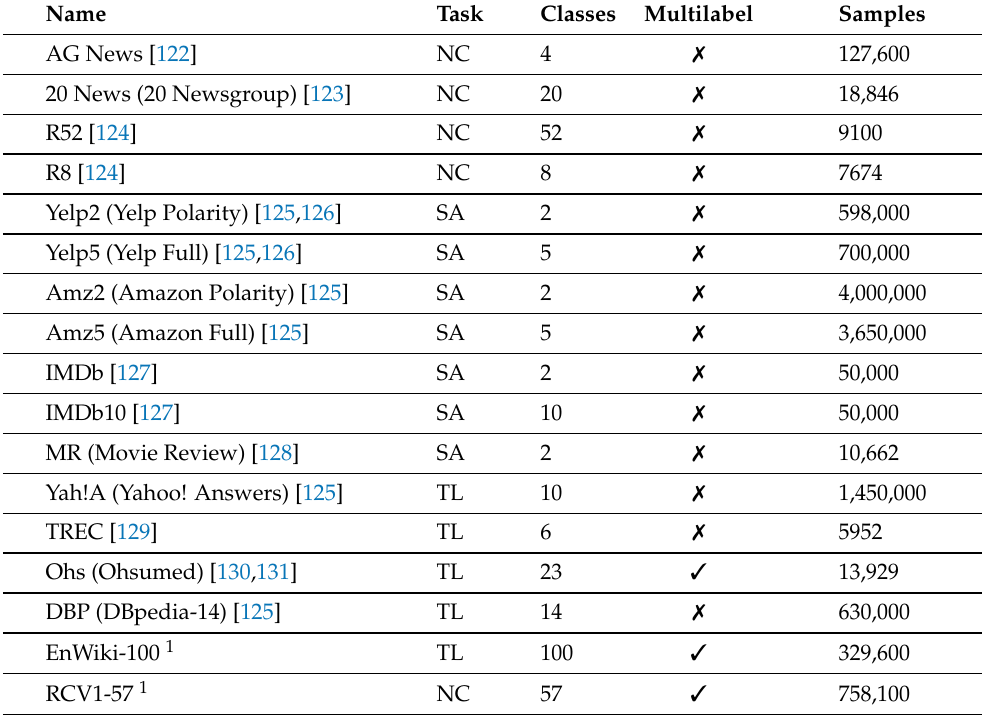
Table 3. English TC